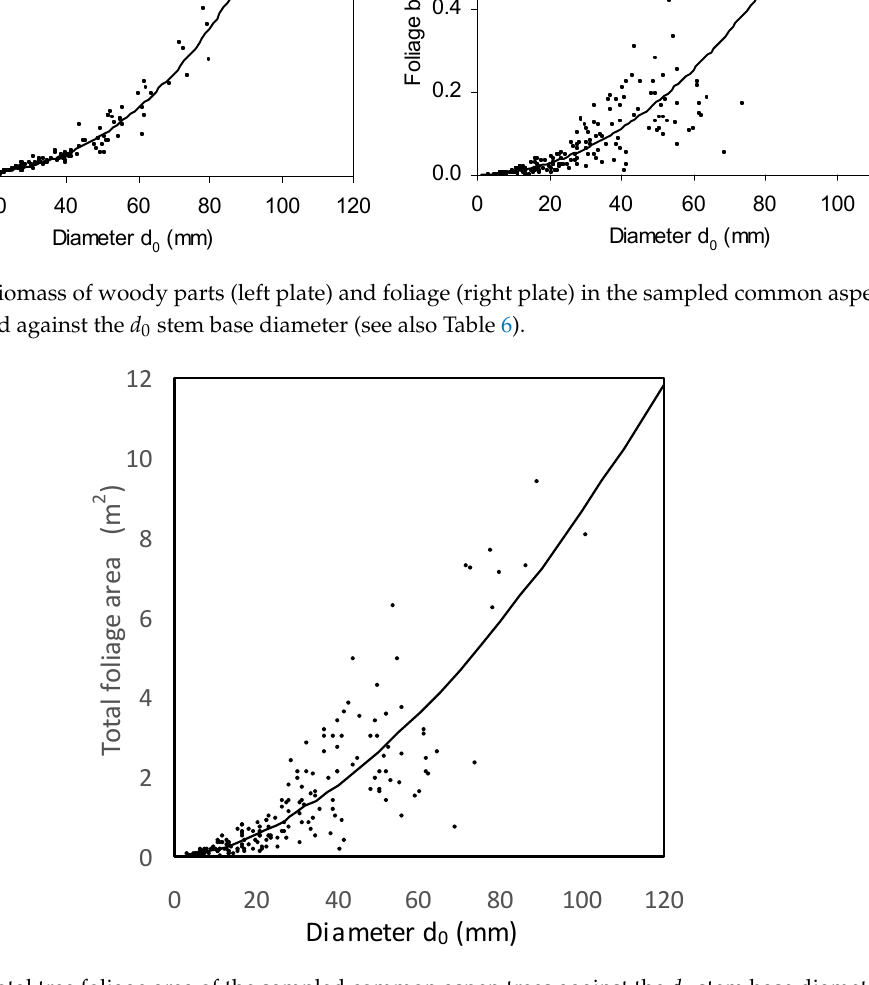
Figure 5. Total tree foliage area of the sampled common aspen trees against the d 0 stem base diameter (see also Table 7). Table 7. Models for calculating tree foliage area, leaf area ratio (LAR), and leaf mass ratio (LMR) in common aspen using stem base diameter as an independent variable, showing their